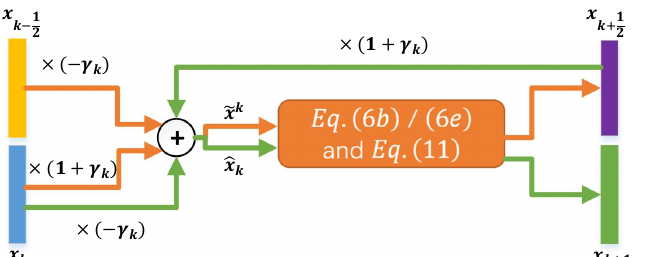
Figure 3. Data flow in the k th phase of EPGN. “ (cid:76) ” represents element-wise sum. Orange and green arrows represent computations in the first ((6a), (6b) and (11) with l = 1/2) and second ((6d), (6e) and (11) with l = 1) stages of EPGN,